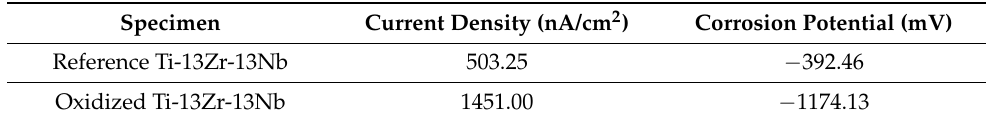
Table 4. Corrosion properties of reference and oxidized Ti-13Zr-13Nb specimens.